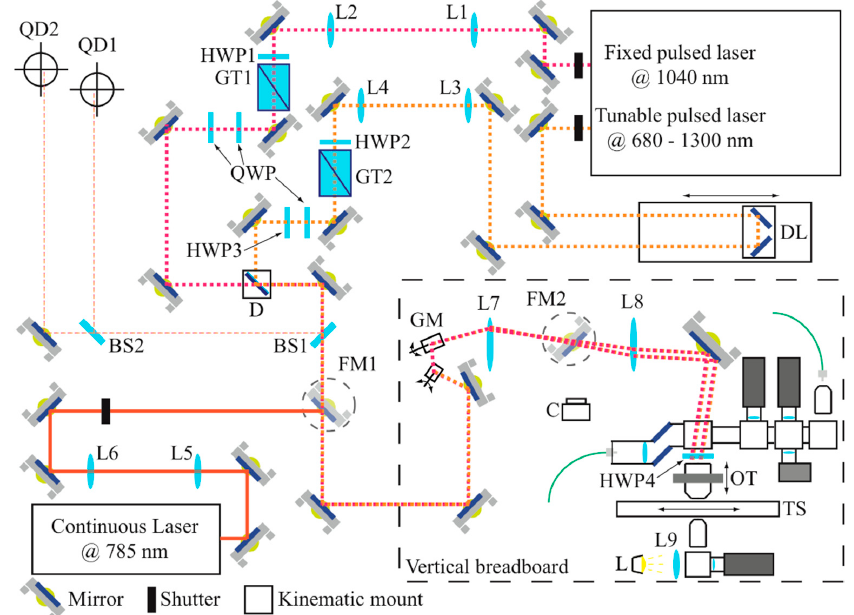
Figure 1. Schematic view of the opto-mechanical system. L1 – L2 lenses of the tunable source telescope, L3 – L4 lenses of the fixed source telescope, L5 – L6 lenses of the continuous-wave laser telescope, L7 scan lens, L8 tube lens, L9 white light lens, HWP half wave plate, QWP quarter wave plate, GT Glan-Taylor polarizer, FM flipping mirrors, BS1 90/10 beam splitter, BS2 50/50 beam splitter, QD quadrant detectors, GM galvanometric mirrors, C camera, OT objective translator, TS xy-translation stage, L white light lamp.